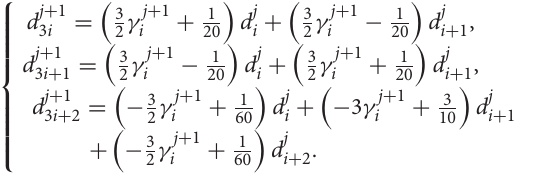
TABLE 5 | Monotonic